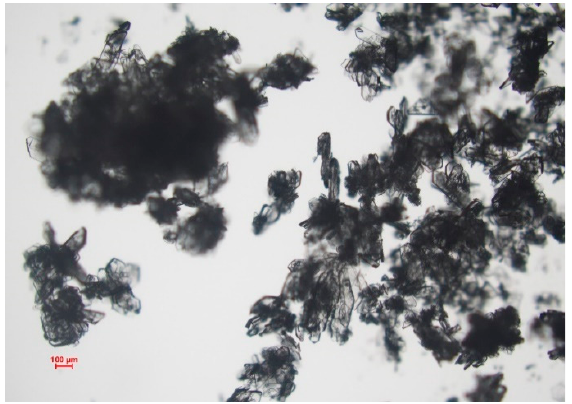
Figure 7. Crystals obtained in the unseeded crystallization with HPMC.